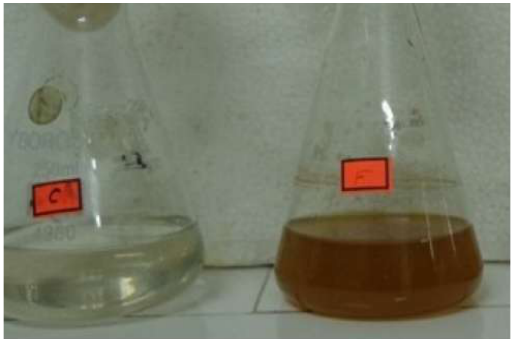
Fig. 2. Cultivation of Fusarium solani on the PDA and Micro- Fig2 Cultivation of Fusarium solani on the PDA and Microscopic observation showing Fig. 1. Biosynthesis of silver nanoparticles by Fusarium solani scopic observation showing micro and macro conidia by Fig 1 Biosynthesis of silver nanoparticles by Fusarium solani showing colour change from showing colour change from colourless to brown colour Lacto phenol cotton blue micro and macro conidia by Lacto phenol cotton blue staining . colourless to brown colour